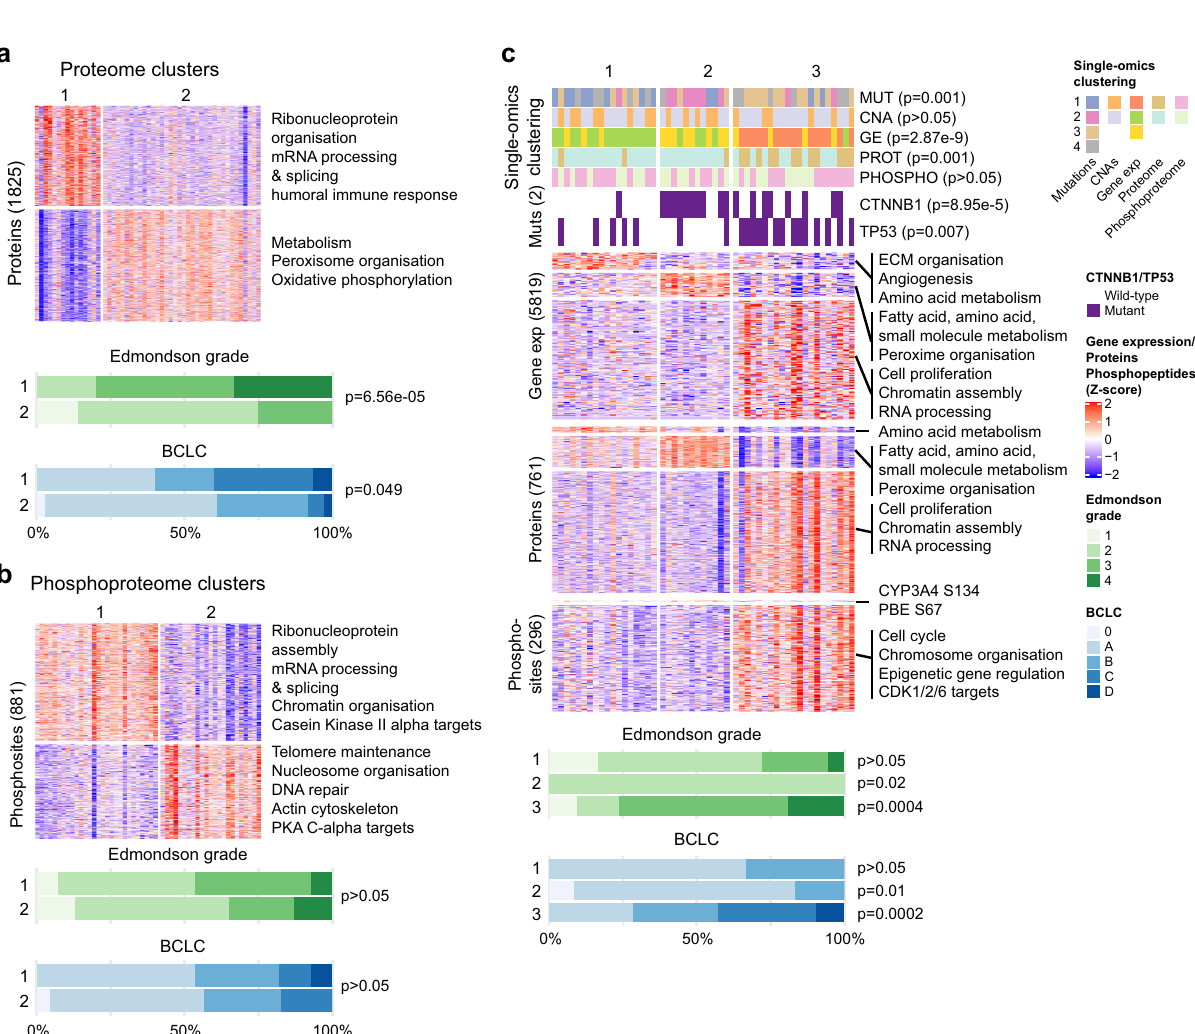
Fig. 5 Integrated phosphoproteomic classi fi cation of HCC. Unsupervised clustering of the ( a ) proteome and ( b ) phosphoproteome data using consensus non-negative matrix factorization. c Integrative clustering of the mutation, copy number alteration, transcriptome, proteome and phosphoproteome using the iCluster method. Copy number alterations not shown in the fi gure as no genomic region differed between clusters. a – c Barplots below show the distribution of Edmondson grade and BCLC between the clusters. Statistical comparison for each cluster was computed using the two-sided Mann – Whitney U test. Source data are provided as a Source Data fi